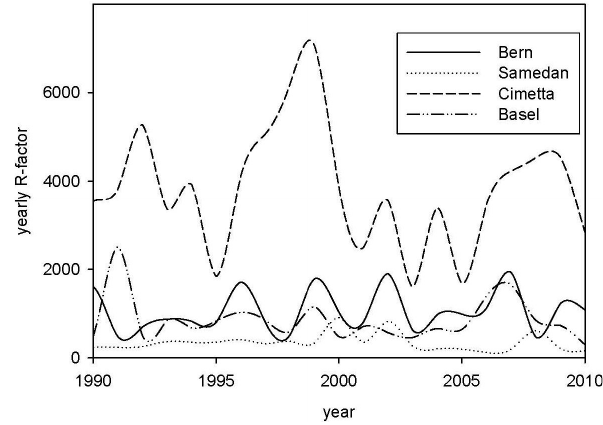
Fig. 6. Annual variability of R -factor for a station in Ticino (Cimetta), Grisons (Samedan) and two stations on the North side of the Alps (Bern,